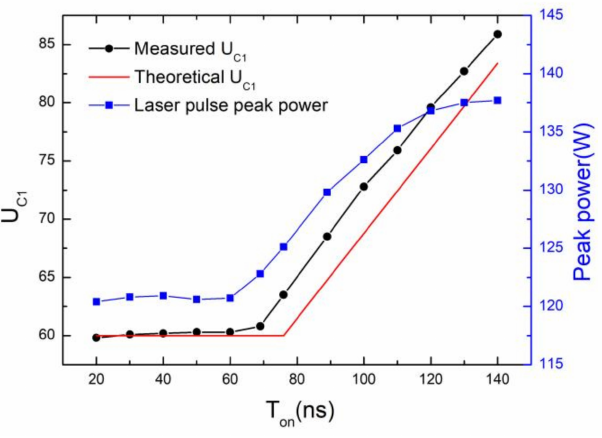
Figure 15. Variation of voltage on C 1 and laser pulse peak power at different T On